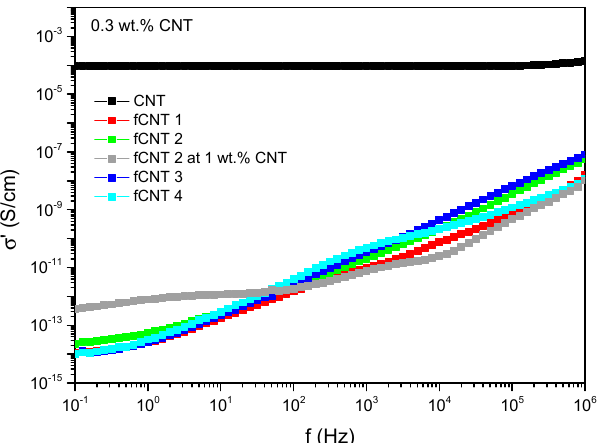
Figure 13. Electrical conductivity of PDMS compounds with functionalized CNTs.